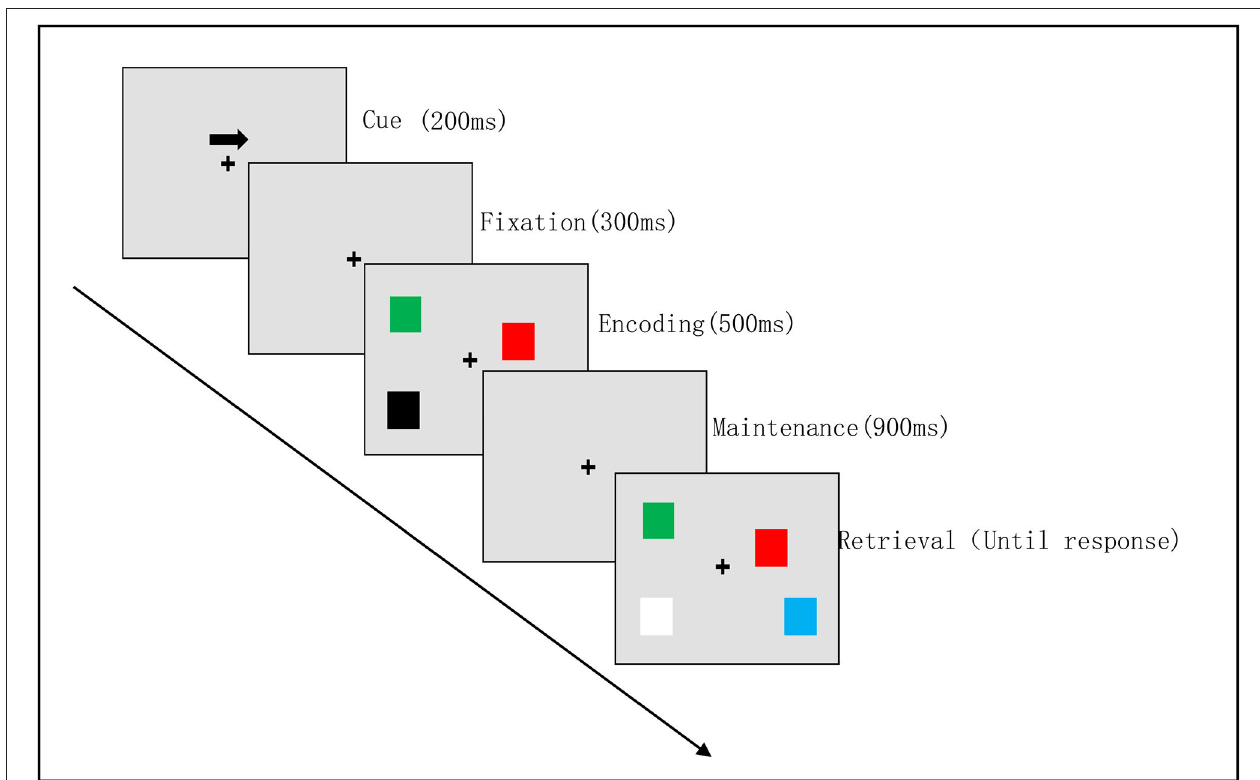
FIGURE 1 | Visual working memory task procedure. Example of a visual memory trial for the right hemifield. The attention phase [cue (200ms) with a fixation (300ms)]; the memory encoding phase (500ms); the maintenance phase (900ms); the retrieval phase (until